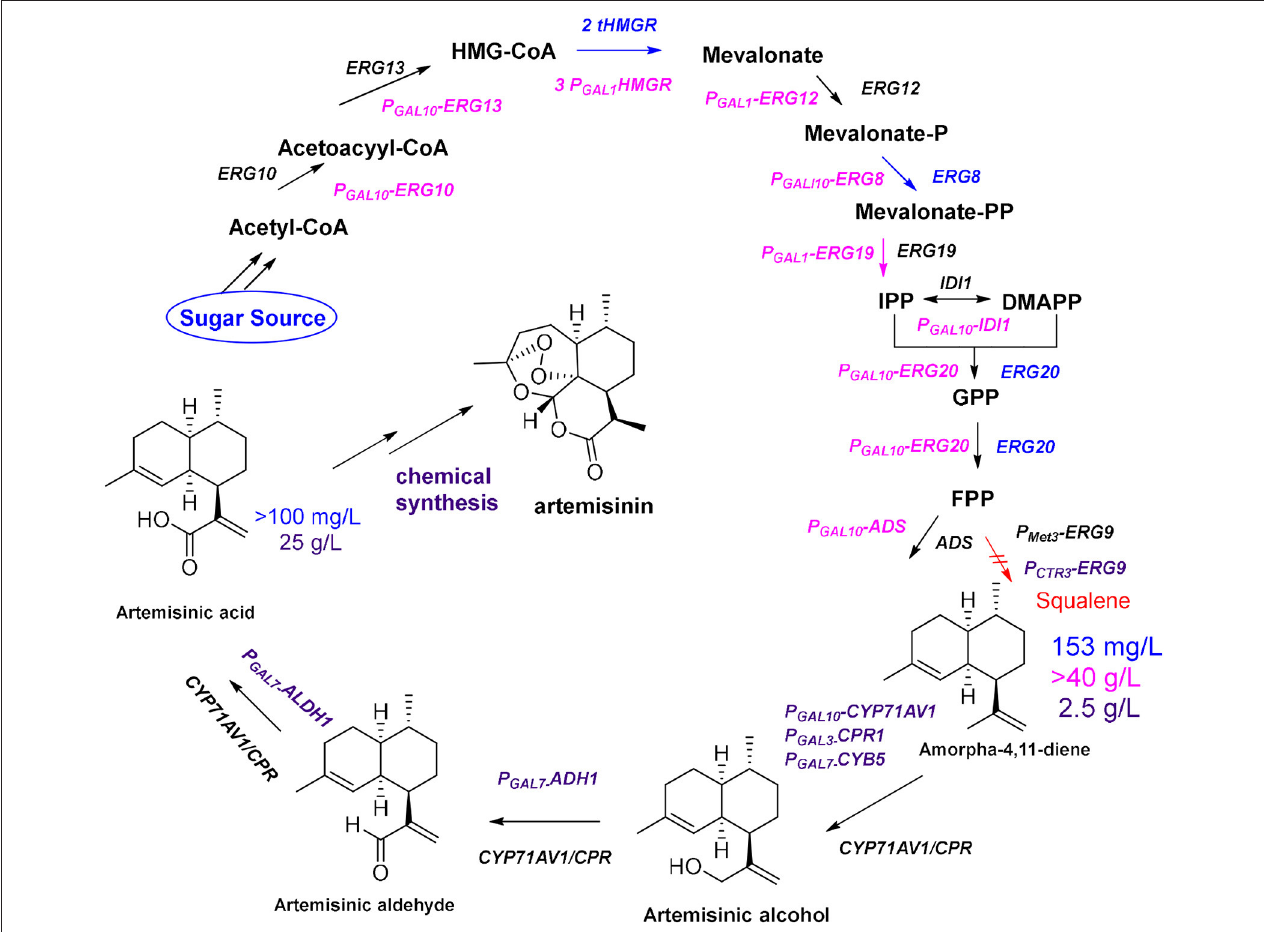
FIGURE 2 | Optimization of the production of artemisinin . Blue route: By enhancing the expression of tHMGR and ERG20 , together with ADS and CYP71AV1/CPR , the yields of amorpha-4,11-diene and artemisinic acid are 153 mg/L and more than100 mg/L, respectively ; Pink route: After using S. cerevisiae CEN.PK2 as chassis and introducing a strong promoter ( GAL 1 or GAL 10 ) before each gene ( ERG10 , ERG13 , tHMG1 , ERG12 , ERG8 , ERG19 , IDI1, and ERG20 ), the yield of amorpha-4,11-diene reaches 40 g/L; Purple route: By enhancing expression two genes (ADH1 and ALDH1) and using the CTR3 promoter suppress expression of ERG9 , the yield of artemisinic acid reached 25 g/L after optimizing fermentation